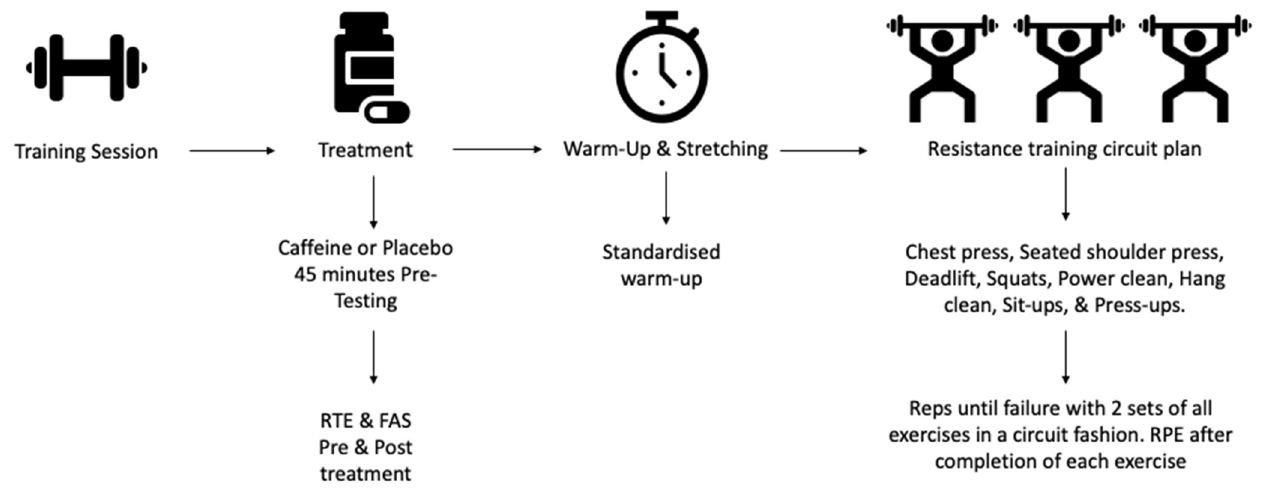
Figure 3. Schematic of Resistance training sessions.